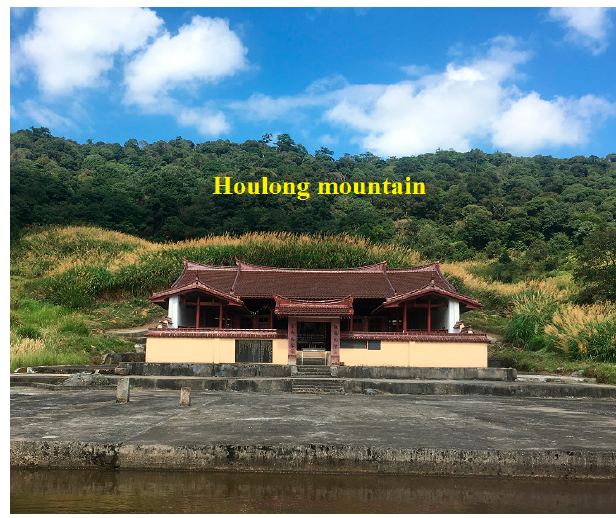
Figure A2. Fengshui forests around the ancestral hall of Lingtou Village.